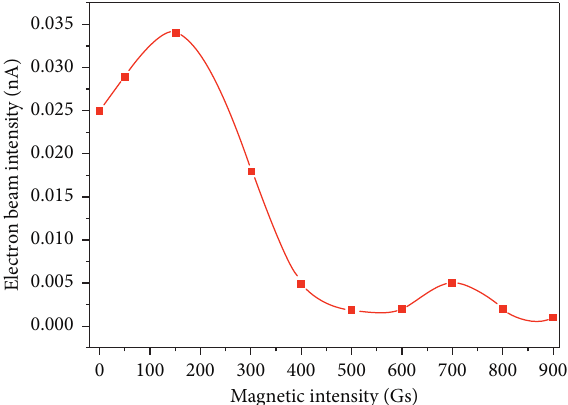
Figure 6: Electron intensity with the various values of the magnetic field from 0 to